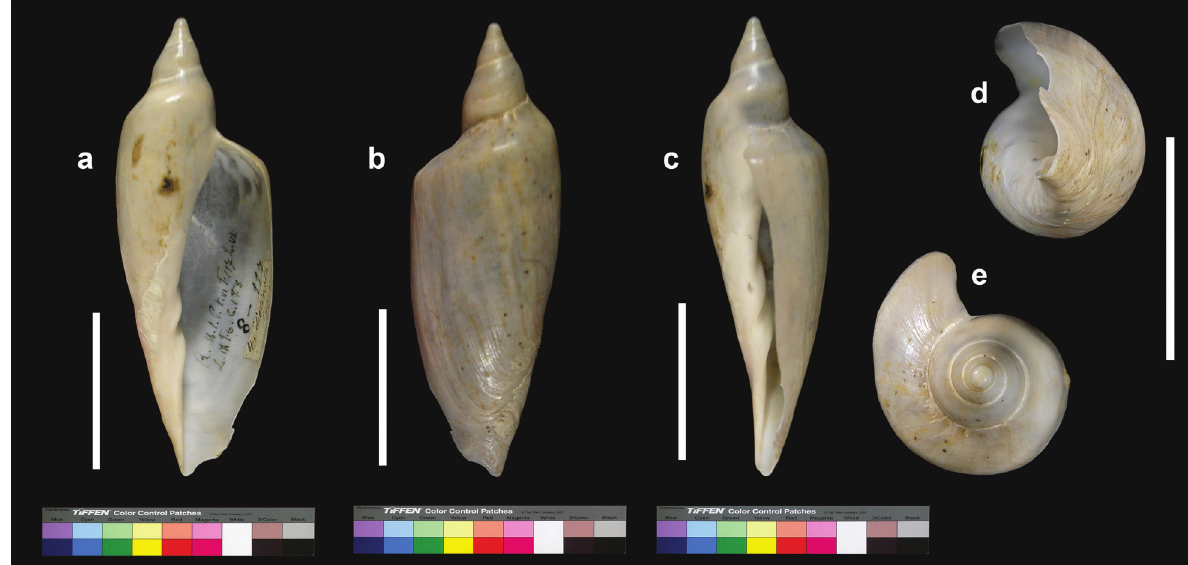
Figure 18. Voluta angulata distincta , specimen figured by Lahille (1895: pl. I, fig. 8; pl. VI, fig. 117; pl. IX, fig. 6). a Apertural view b Dorsal view c Lateral view d Umbilical view e Apical view. Scale bars: 5 cm.